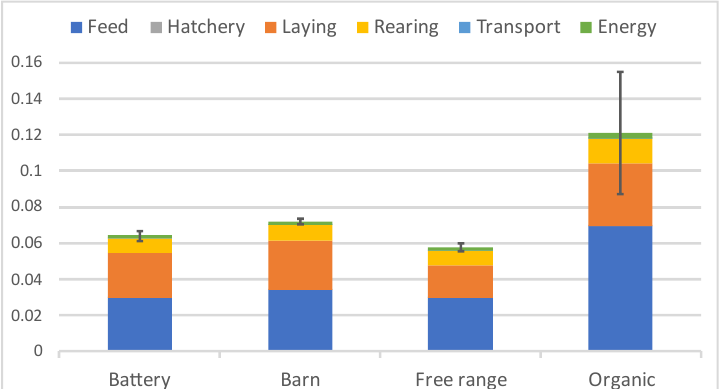
Figure 2. Normalized and weighted results for the different laying systems using Environmental Footprint 3.0 for one kilogram of eggs.